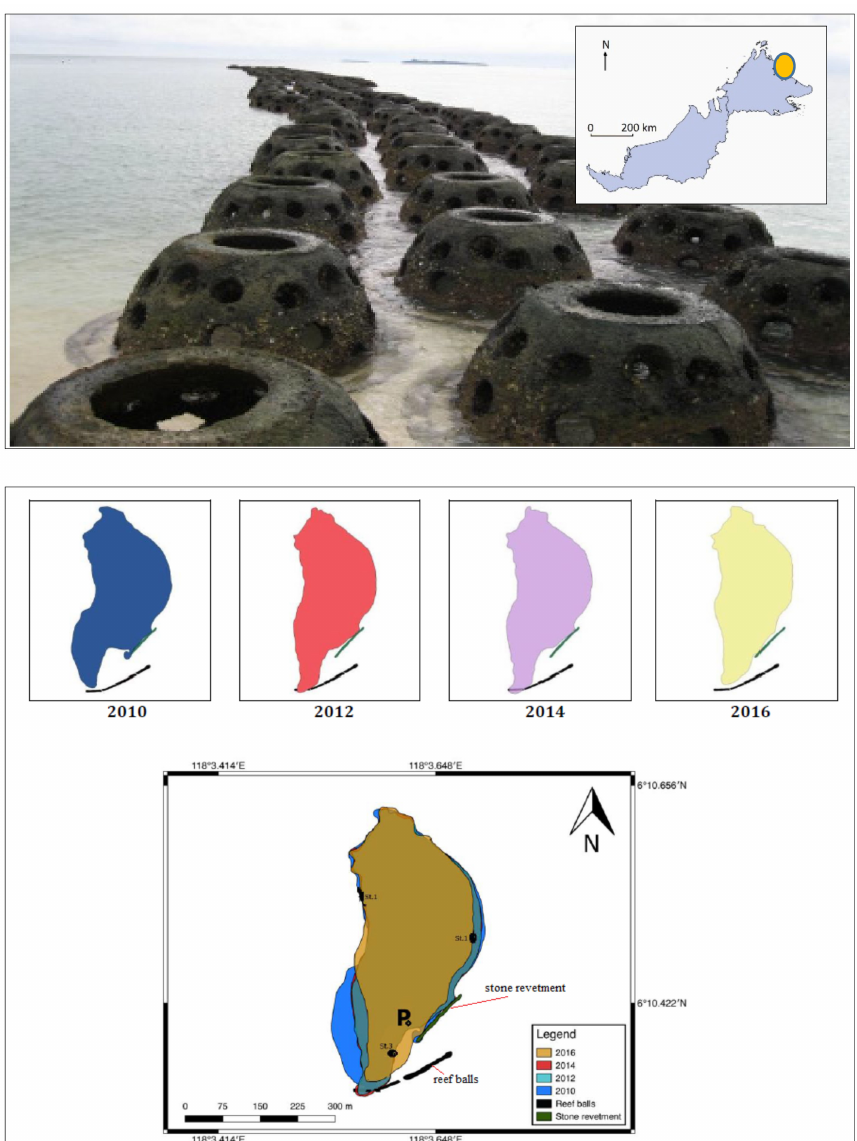
Figure 11. Innovative reefball structure and shoreline changes in Pulau Selingan [92]. ‘Reprinted from Effect of artificial structures on shoreline profile of Selingan Island, Sandakan, Sabah, Malaysia, 2018; open access publication by BJoMSA